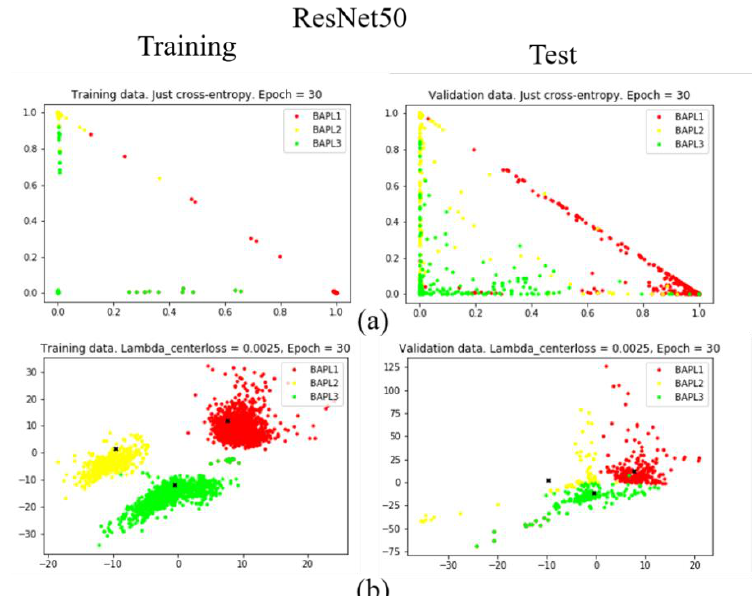
Figure 8. Distributions of training samples, represented by the reduced two-dimensional ResNet50 features: ( a ) conventional loss function; ( b ) proposed joint loss function. Left: training data; right: test data.